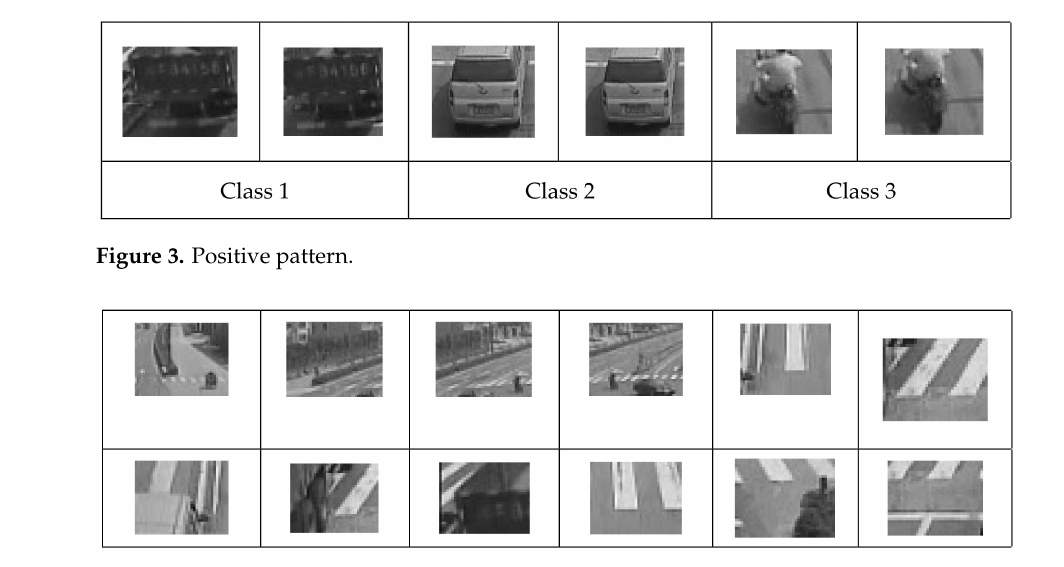
Figure 4. Negative pattern.